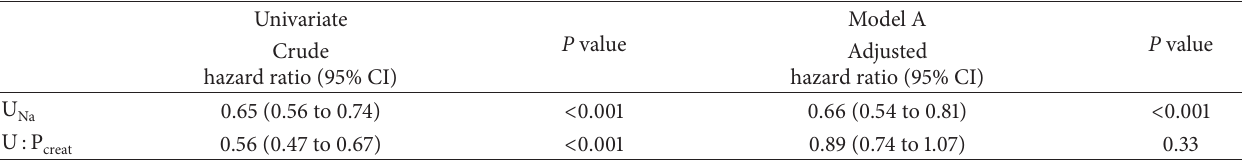
Table 5: Cox proportional hazards models for the risk of cardiovascular death.